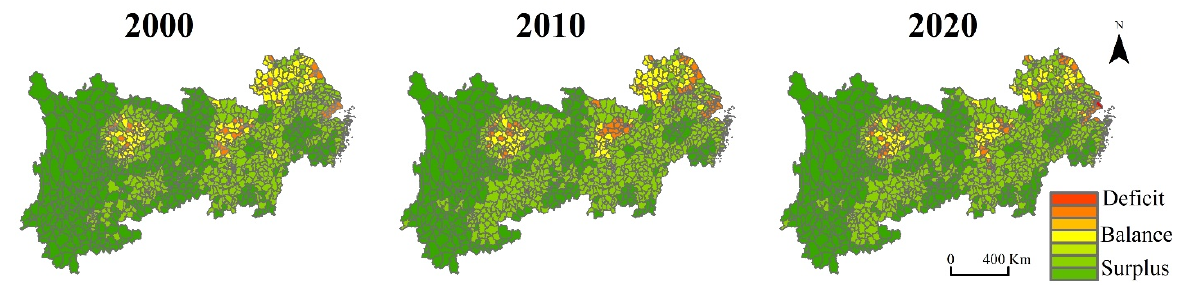
Figure 6. Spatial distribution of CESDR in the YREB from 2000 to 2020.